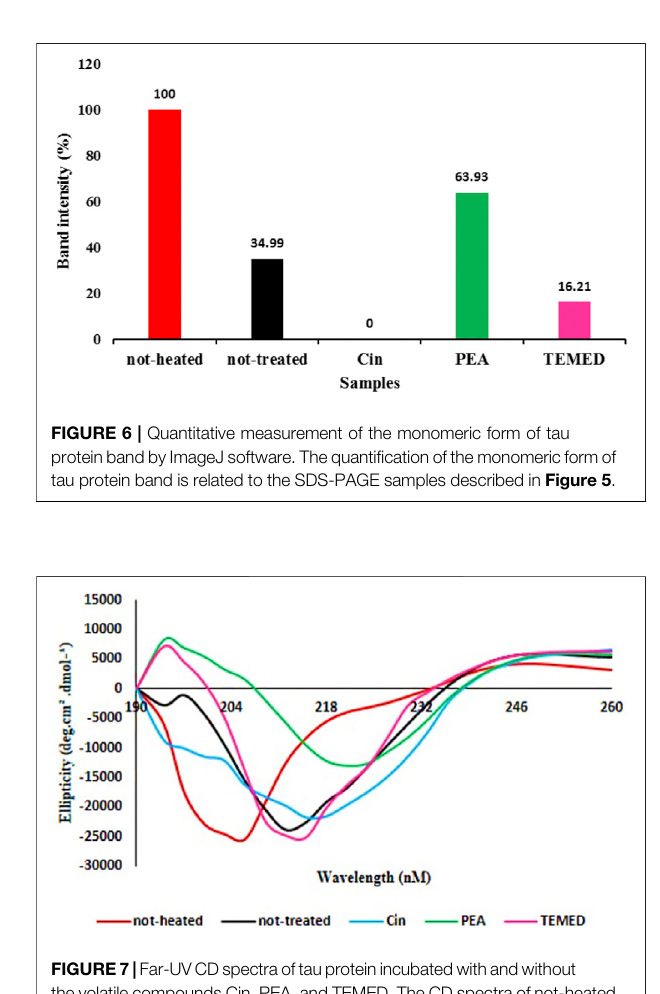
Frontiers in Pharmacology |